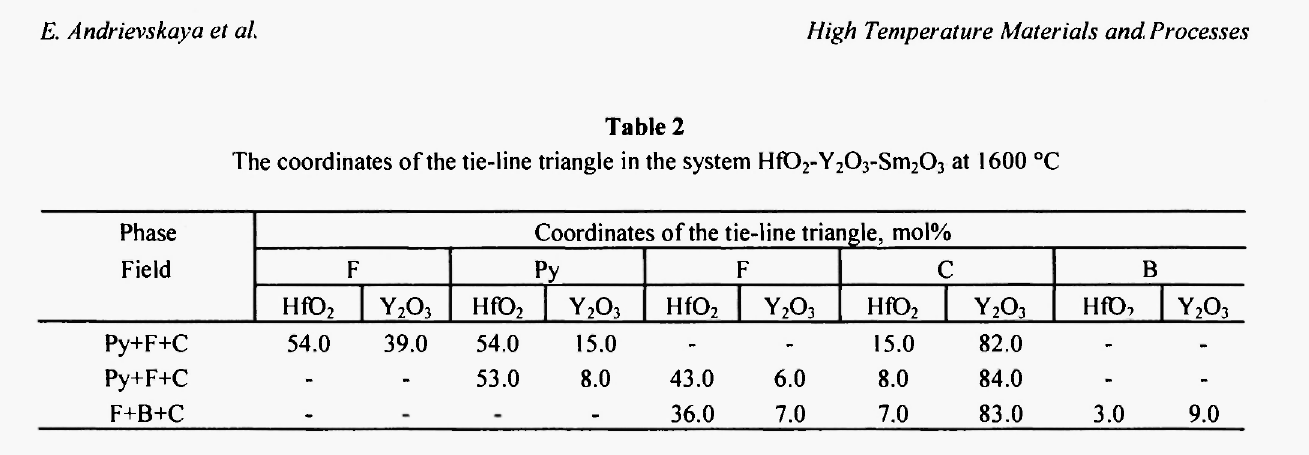
The coordinates of the tie-line triangle in the system Hfö 2 -Y 2 0 3 -Sm 2 0 3